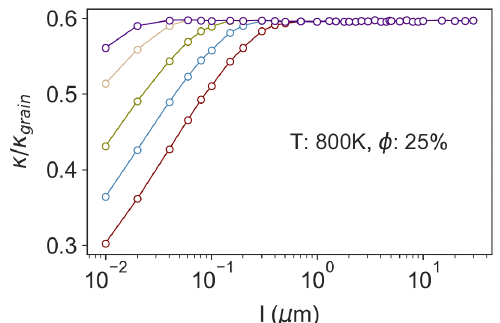
Figure 3. Thermal conductivity of polycrystalline Si 0.8 Ge 0.2 containing cylindrical nanopores com- pared to the same polycrystalline material without pores. The thermal conductivity reduction is plotted vs. pore spacing, l , for material with effective grain sizes of 200 nm (red), 100 nm (blue), 50 nm (green), 20 nm (brown) and 10 nm (purple). For all cases, the pore fraction is φ =